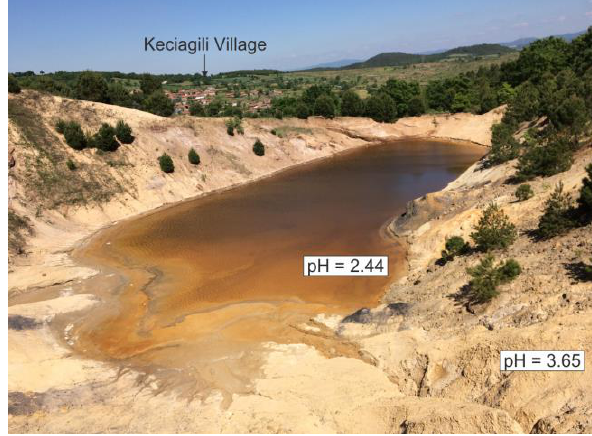
Figure 2. Snapshot from acid mine lake and mine wastes